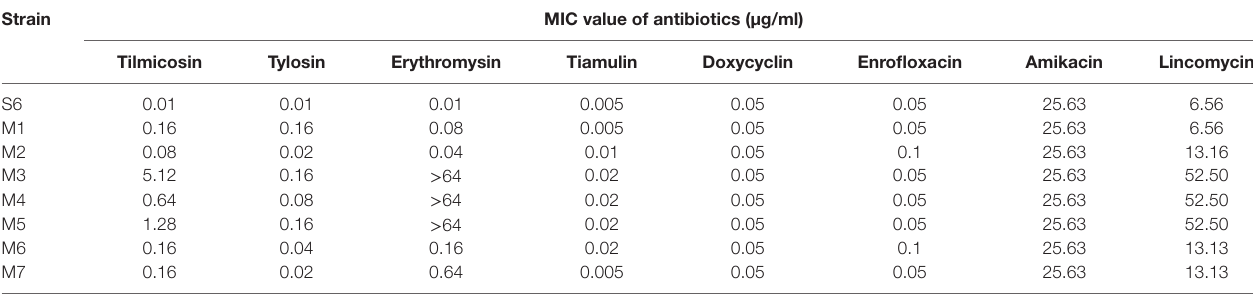
TABLE 3 | The MIC of six antimicrobial agents against M. gallisepticum S6 and M1–M7 strains. Strain MIC value of antibiotics (μg/ml) Tilmicosin